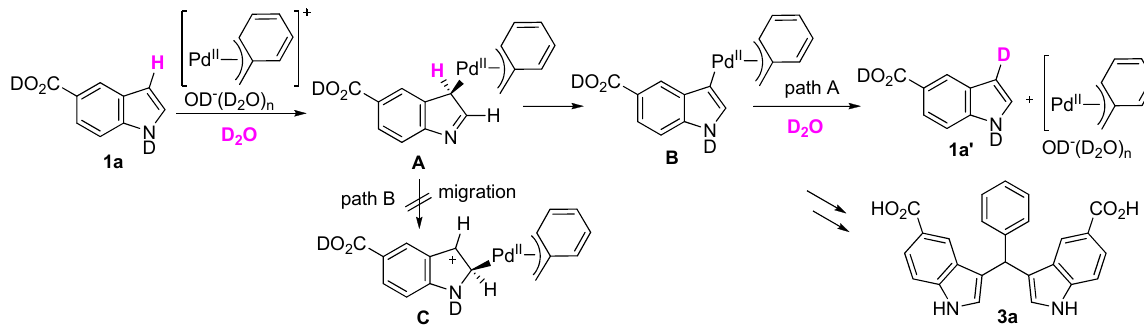
Table 2. C–H bond activation at the C3-position of indole-5-carboxylic acid 1a a